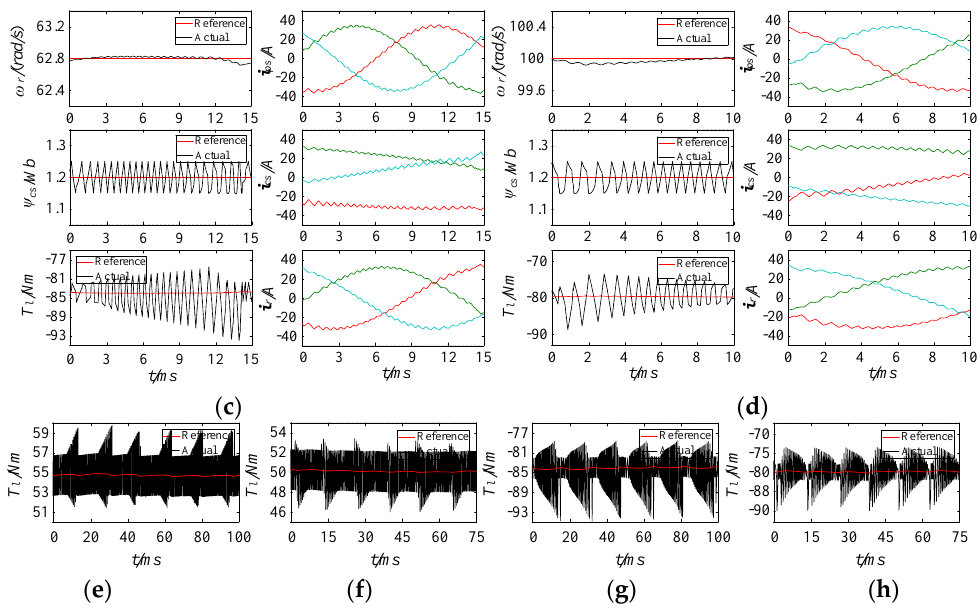
Figure 12. Simulation waveforms of conventional DTC. ( a ) 55 Nm, 62.8 rad/s (motoring mode); ( b ) 50 Nm, 100 rad/s (motoring mode); ( c ) −85 Nm, 62.8 rad/s (generating mode); ( d ) −80 Nm, 100 rad/s (generating mode); ( e ) 55 Nm, 62.8 rad/s; ( f ) 50 Nm, 100 rad/s; ( g ) −85 Nm, 62.8 rad/s; ( h ) −80 Nm, 100 rad/s.